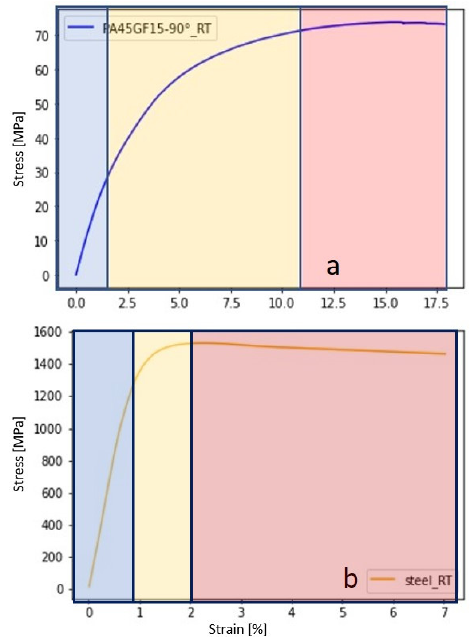
Figure 1. Exemplary stress–strain curves of SFRP (PA46 GF15) at ( a ) and metal (steel) at ( b ).